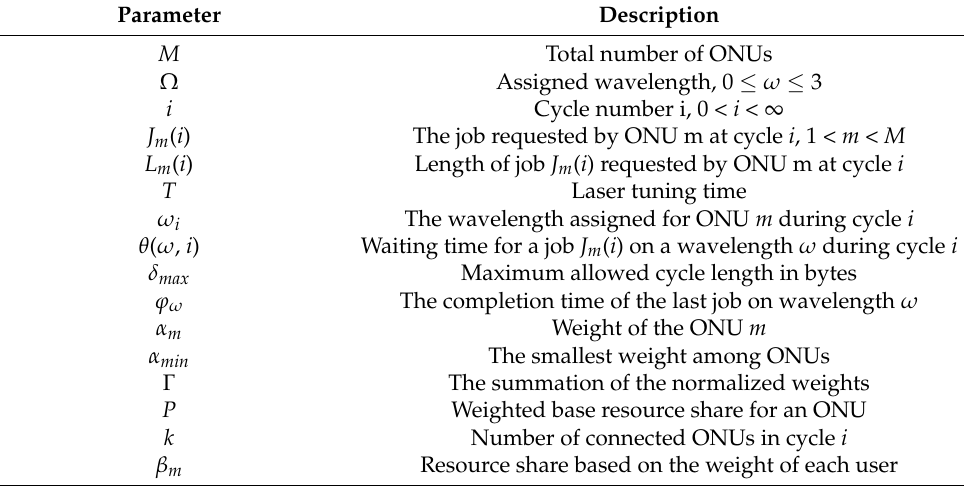
Table 2. Parameters of the LTT-aware QoS based